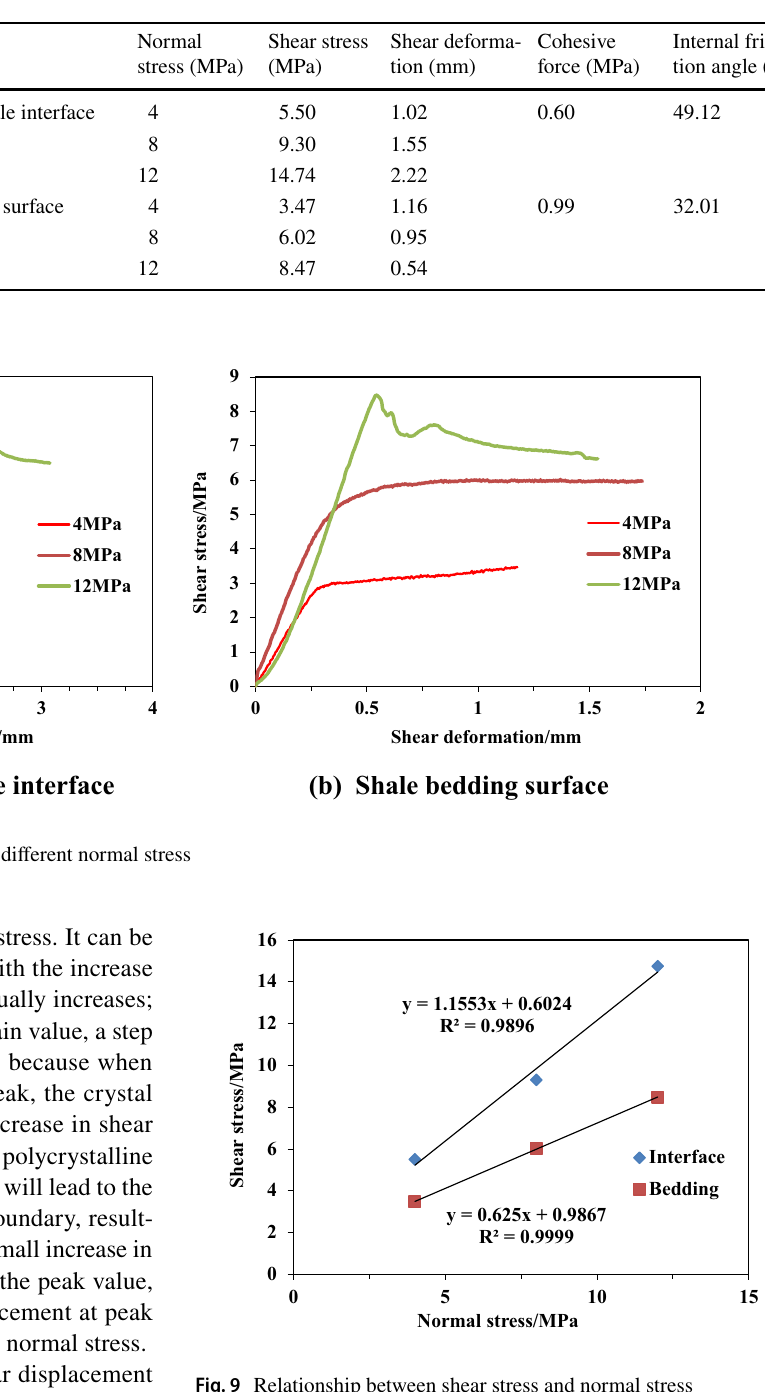
Fig. 9 Relationship between shear stress and normal